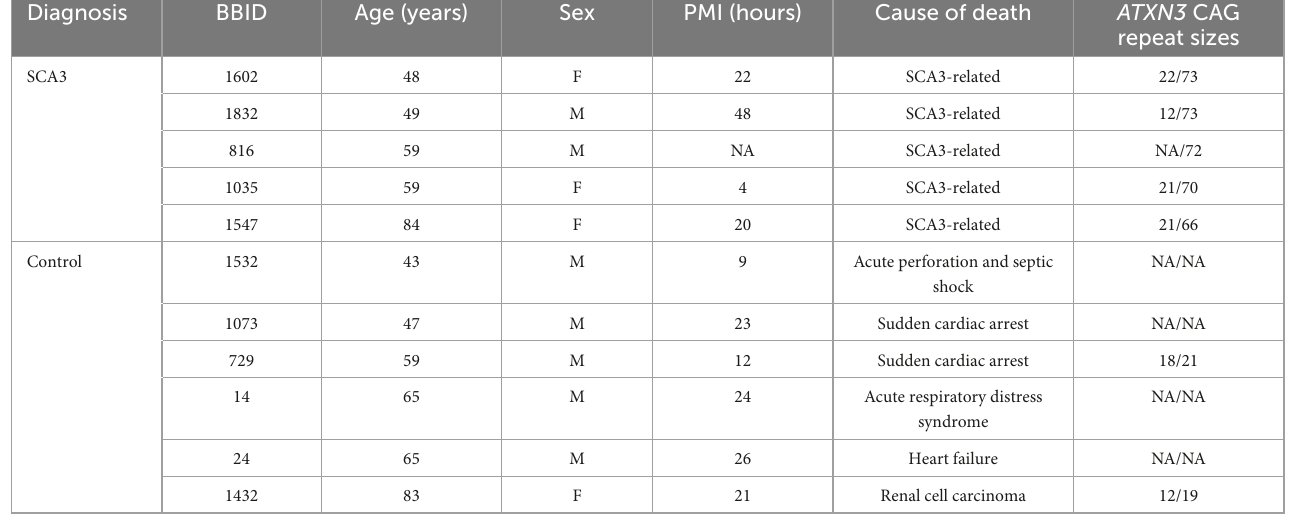
TABLE 1 Information on human post-mortem tissue